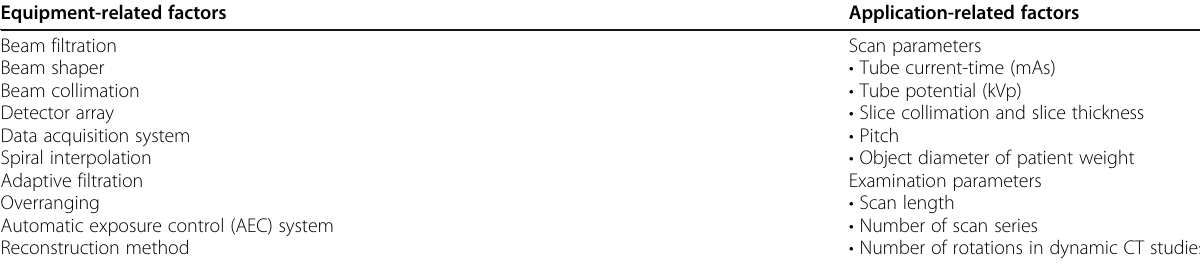
Table 3 Factors affecting radiation dose in CT